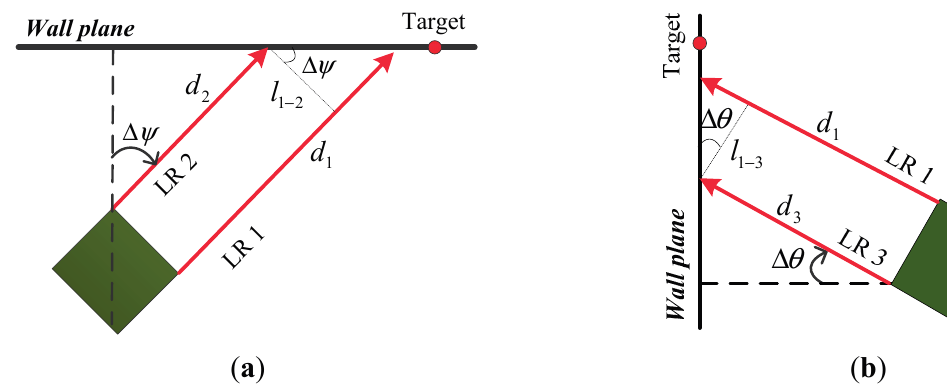
Figure 5. Calculation of the attitude changes. ( a ) Calculation of the yaw angle change; ( b ) Calculation of the pitch angle